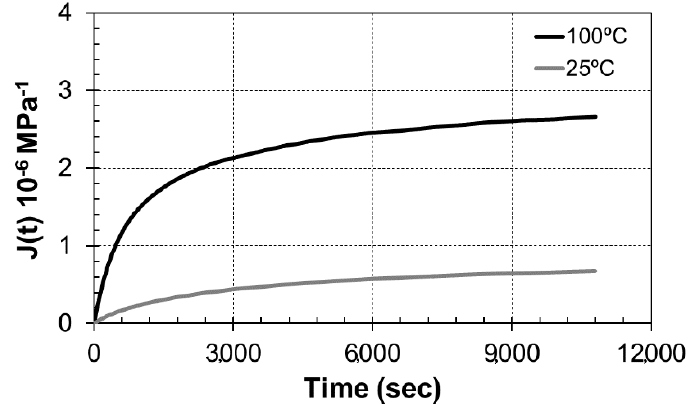
Figure 20. Creep compliance as a function of time for a nanocomposite made of 15 v% cellulose and 20 wt. % STO nanoparticles.